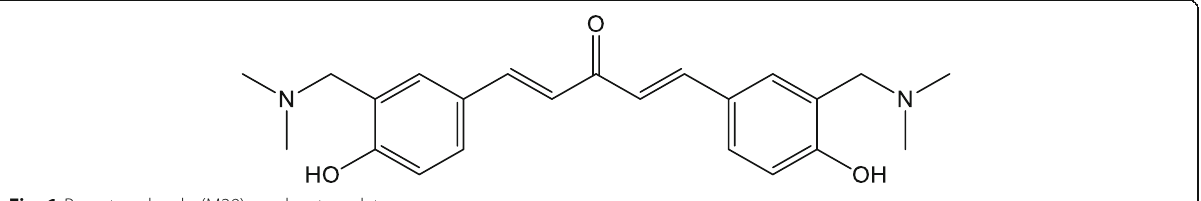
Fig. 1 Parent molecule (M29) used as template